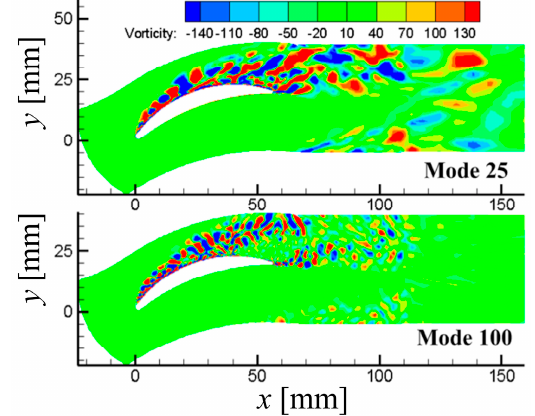
Figure 11. 25th and 100th modes of flow field by POD method.